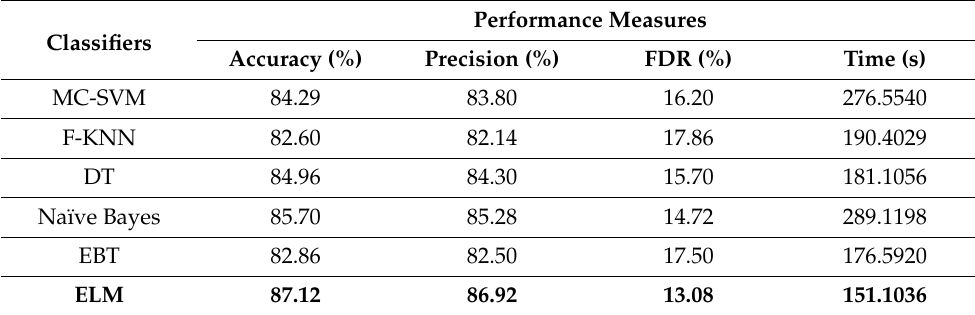
Table 7. Classification accuracy using EMI-based feature selection for ISIC2018